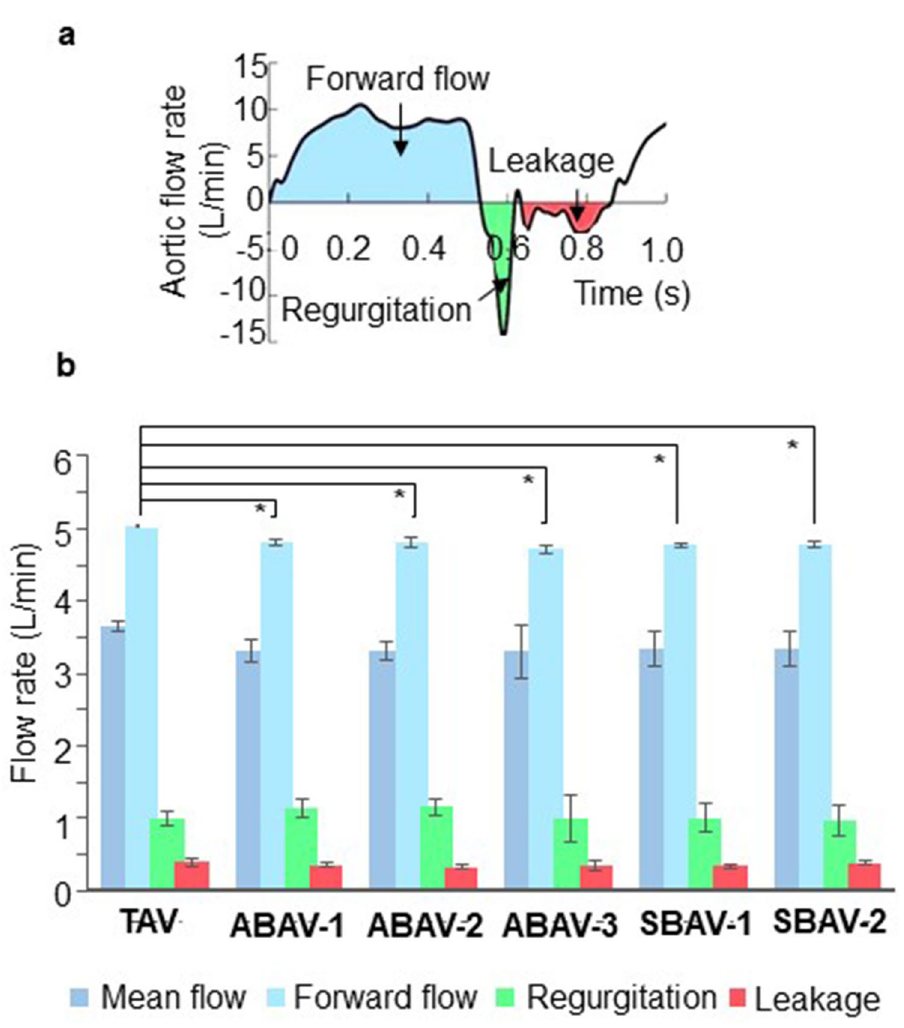
Figure 5. Comparison of the flow among the five bicuspid aortic valves (BAVs) and the tricuspid aortic valve (TAV). ( a ) A representative waveform of the aortic flow rate in TAV and definitions of forward flow, regurgitation, and leakage (blue, green, and red areas, respectively). ( b ) Comparison of the mean aortic flow, forward flow, regurgitation, and leakage among the six valve morphologies (six samples, each). No differences in the mean aortic flow, forward flow, regurgitation, and leakage are observed among the five BAVs. Forward flow is significantly greater in TAV than in BAVs. The mean flow, regurgitation, and leakage are comparable between BAVs and TAV. *Statistical difference ( p < 0.001, Tukey honestly significant difference test) in comparison of the forward flow between TAV and each BAV. The error bar indicates the mean ±